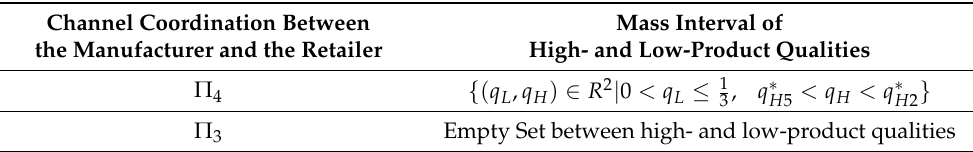
Table 4. Coordination strategy between the manufacturer and the retailer. Channel Coordination